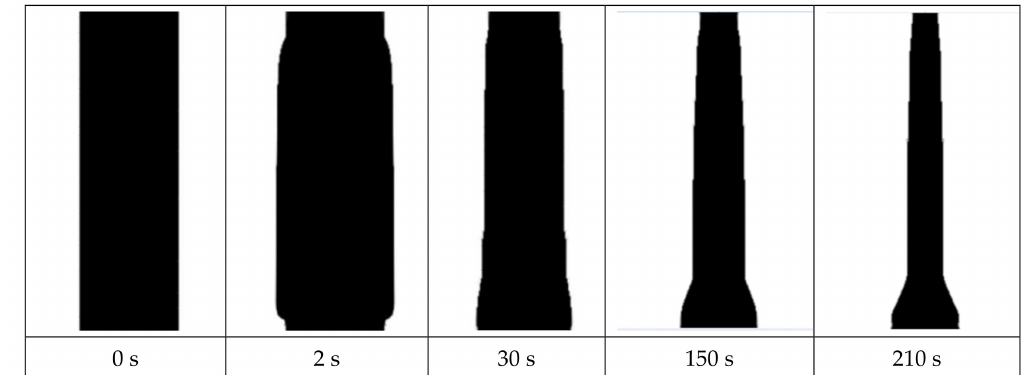
Figure 7. The bar profiles at di ff erent melting times.